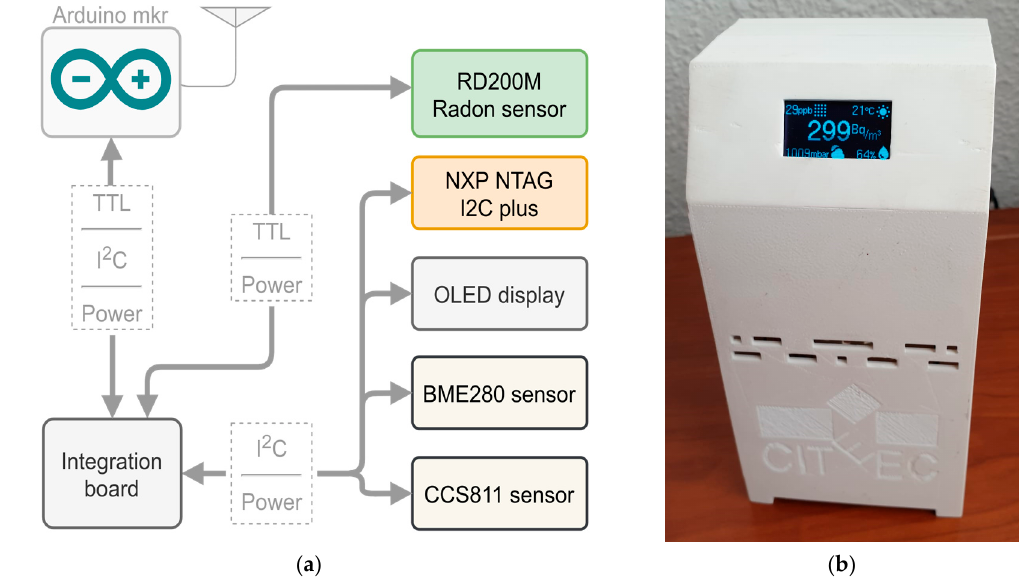
Figure 1. ( a ) Monitoring devices sketch. ( b ) Final device assembled in a 3D-printed enclosure.